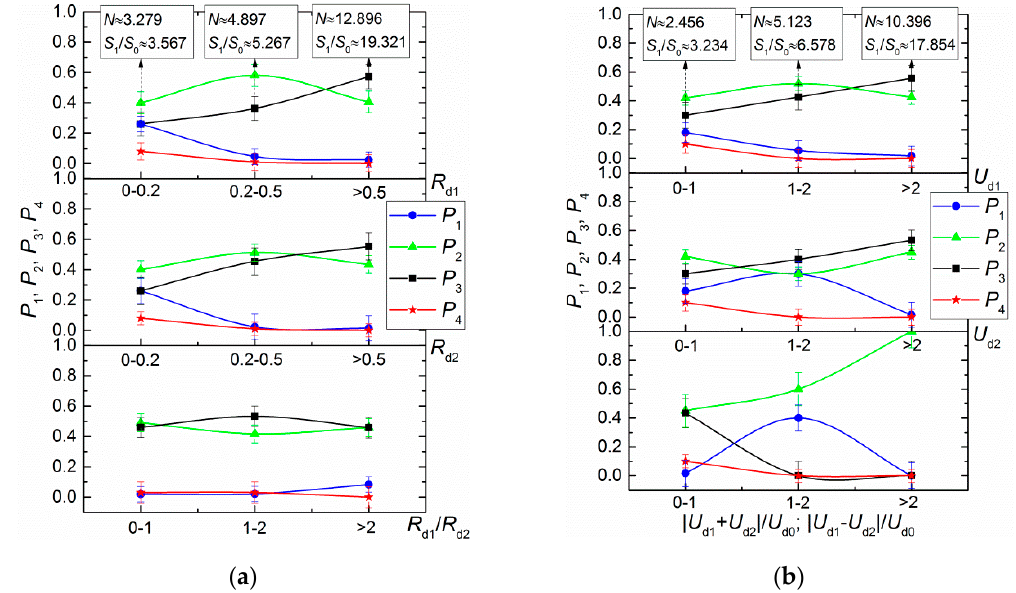
Figure 3. Frequency of each of four droplet interaction modes ( P 1 —coalescence, P 2 —separation, P 3 —disruption, P 4 —bounce) when sizes and their ratios were varied ( a ), when velocities and relative velocity were varied ( b ).